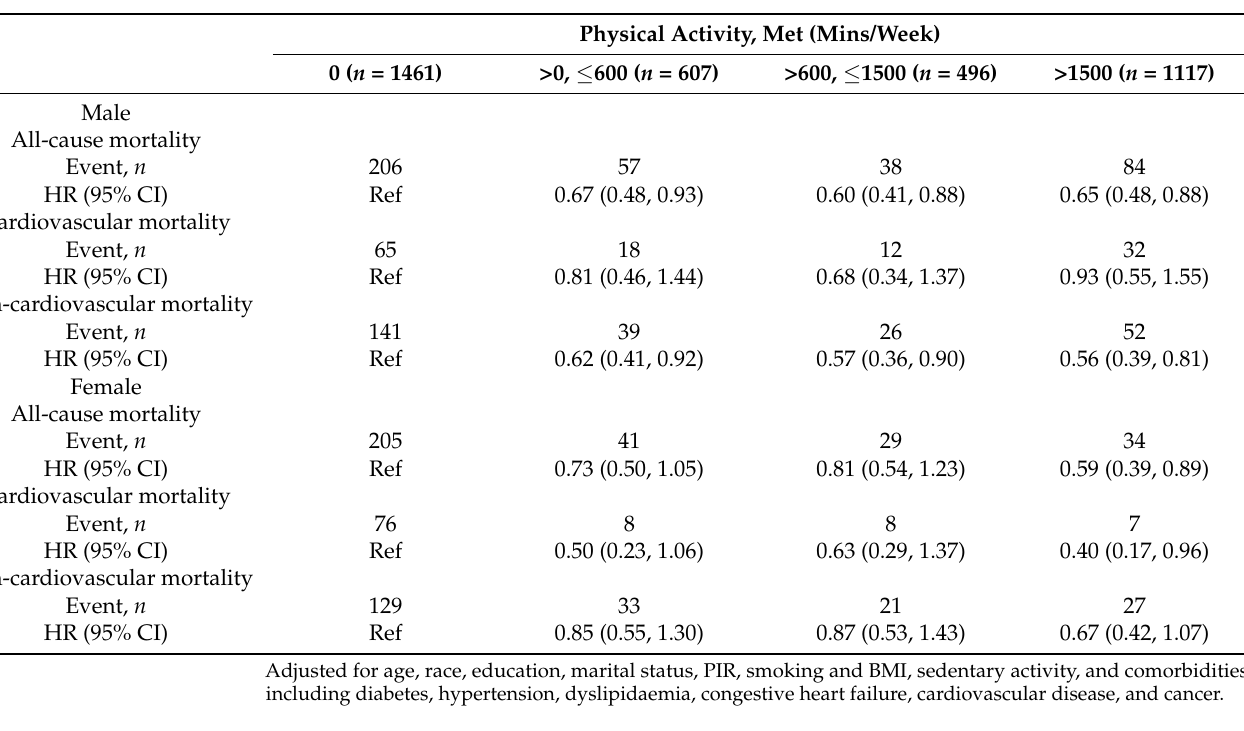
Table 2. Estimated hazard ratios from the Cox regression analyses of the association between mortality and the physical activity level in male and female.